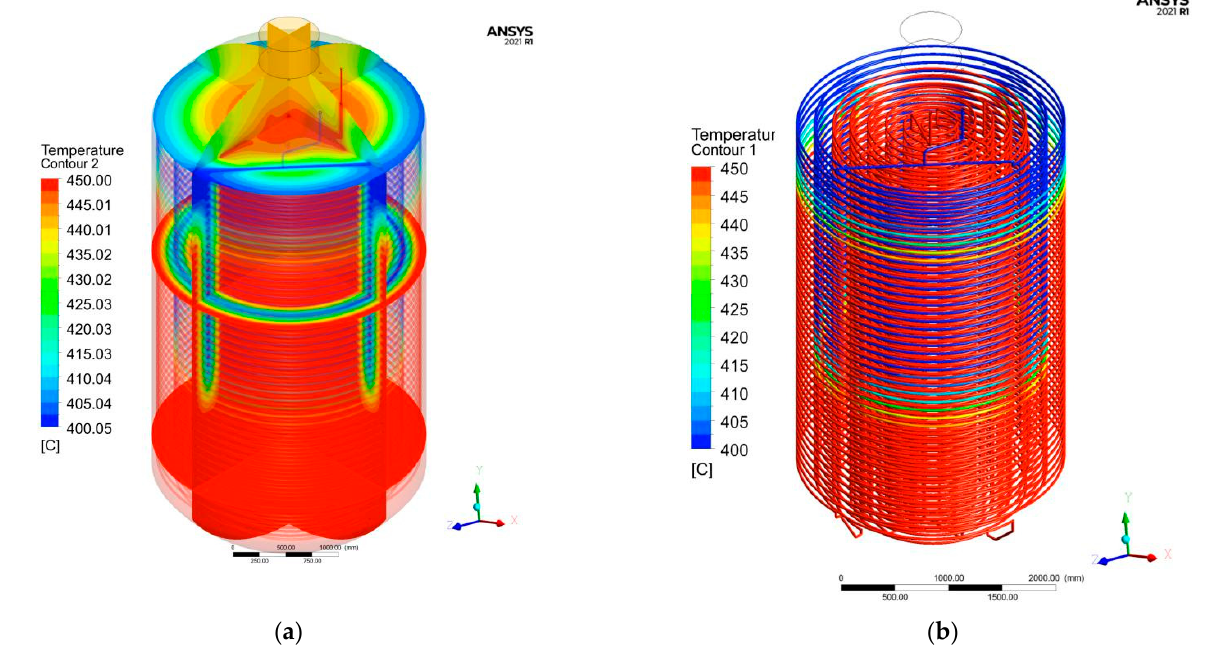
Figure 7. Simulation results of temperature field. ( a ) Nephogram of temperature distribution in carbonization kettle; ( b ) Temperature distribution in Coils.